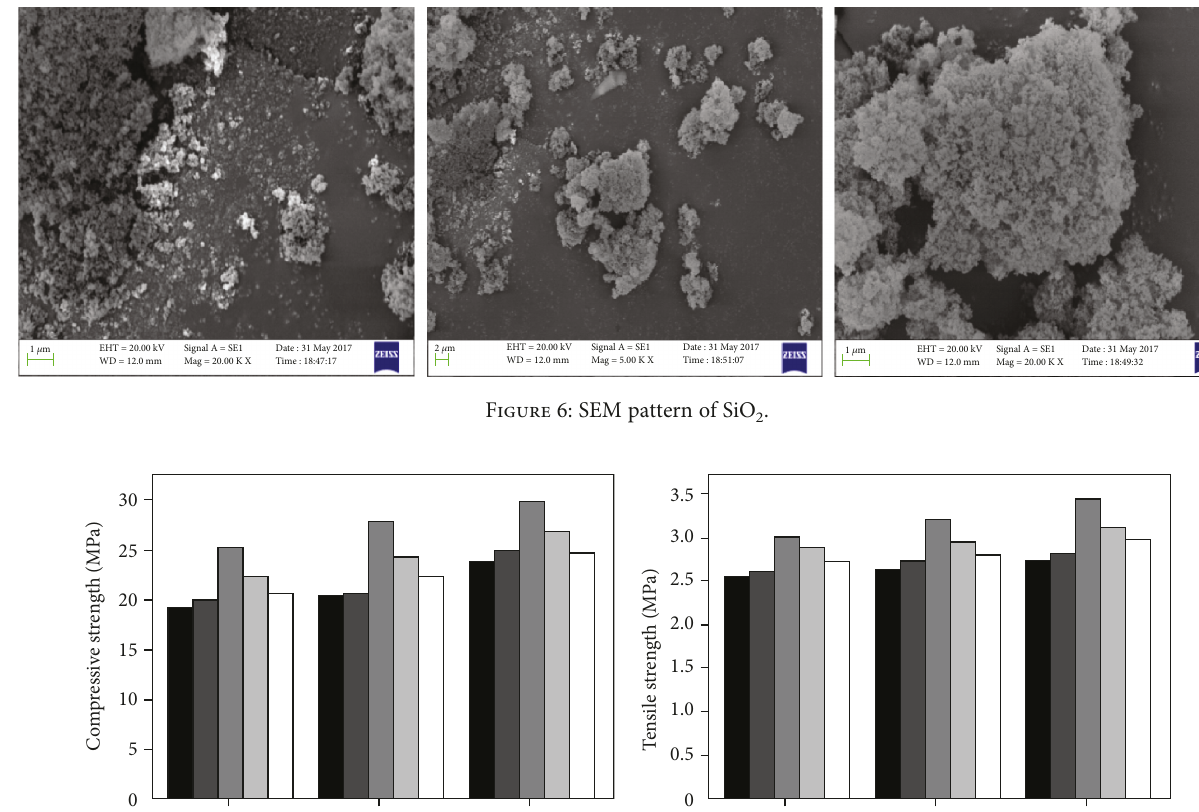
Figure 7: Strength of reinforced oil well cement stone.